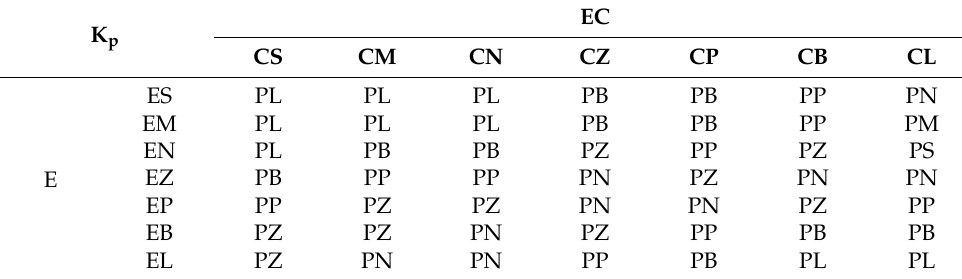
Table 1. Fuzzy rule table of control parameter K p .